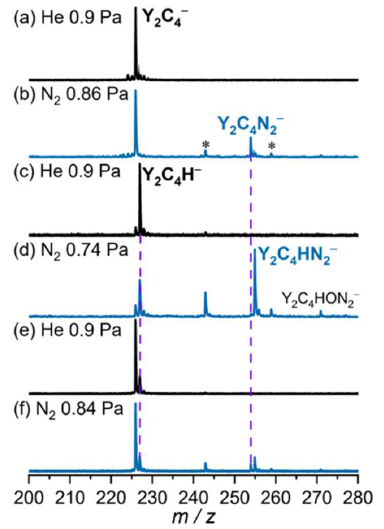
Figure 1. TOF mass spectra for the reactions of ( a ) mass-selected Y 2 C 4 − with He and ( b ) N 2 for 6 ms, ( c ) mass-selected Y 2 C 4 H − with He and ( d ) N 2 for 14 ms, and ( e ) the coexisting Y 2 C 4 − and Y 2 C 4 H − clusters with ( f ) N 2 for 10 ms, respectively. The effective reactant gas pressures are shown. The asterisked peaks ( * ) are Y 2 C 4 OH − and Y 2 C 4 O 2 H − , due to the reactions with residual water in the LIT. Black bold, blue bold and black font represent reactants, products and impurities,